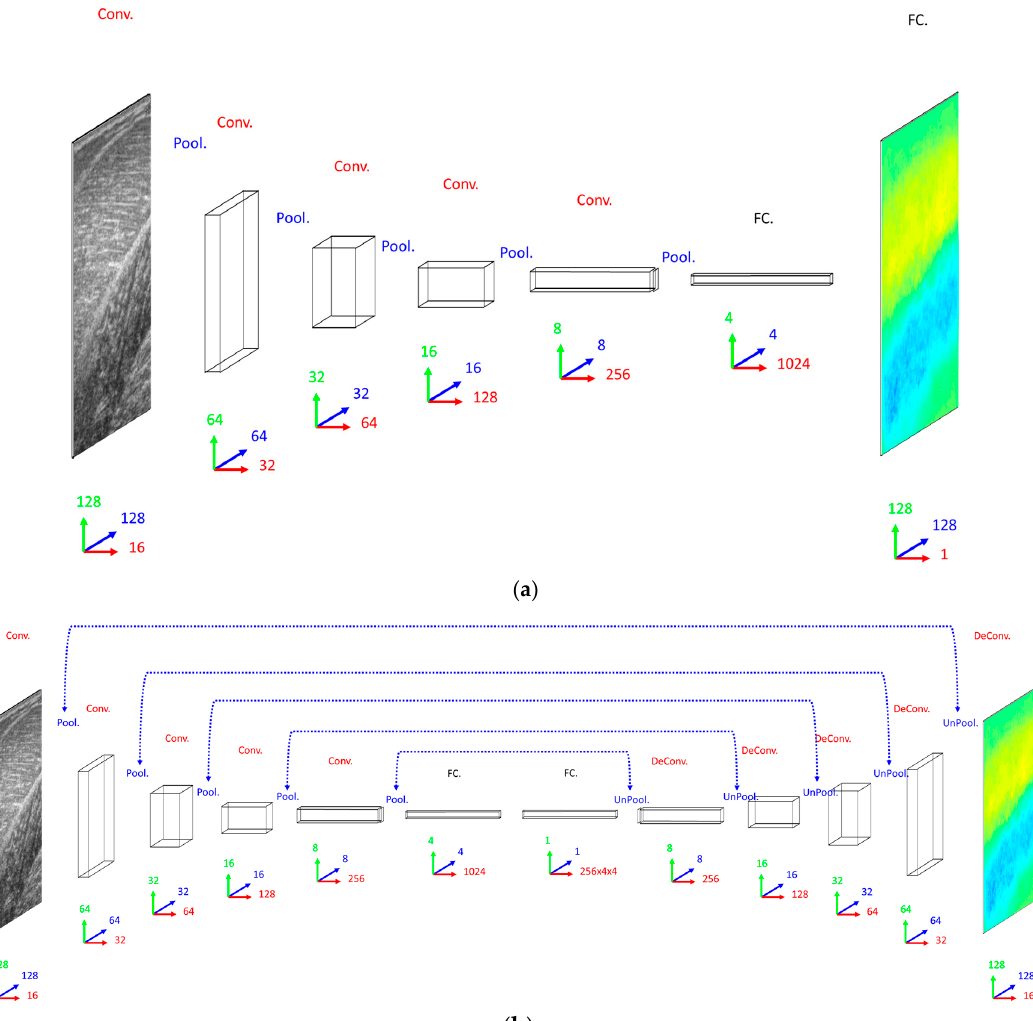
Figure 1. Network schemas. ( a ) Top: Convolutional Neural Network (CNN) with 5 convolutional layers (Conv.), 5 max-pooling layers (Pool.) and 2 fully connected layers (FC.). Bottom: Residual Neural Network (ResNet) with 25 convolutional layers (Conv.), 5 max-pooling layers (Pool.) and 2 fully connected layers (FC.), where residual (identity) connections are shown (dashed blue lines). ( b ) Deconvolutional Neural Network (DCNN) with 5 convolutional layers (Conv.), 5 max-pooling layers (Pool.), 5 deconvolutional layers (DeConv.), 5 max-un-pooling layers (UnPool.) and 2 fully connected layers (FC.), where dashed blue lines indicate argmax link between un-pooling and pooling layers. Network size/complexity and runtime (forward pass, average over 1000 runs) is indicated below respective schematics. In all graphics, blue, green and red arrows/numbers respectively represent horizontal (pixels), vertical (pixels) and feature (nodes) dimensions per layer.